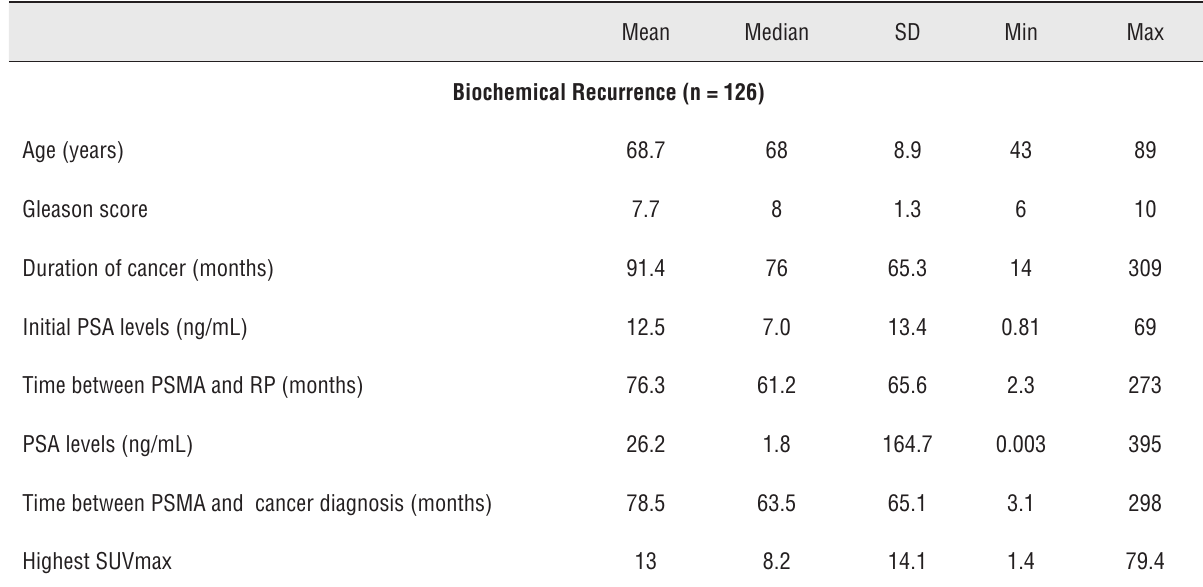
Table 1 - characteristics of patients submitted to 68Ga-pSMA pET/cT.